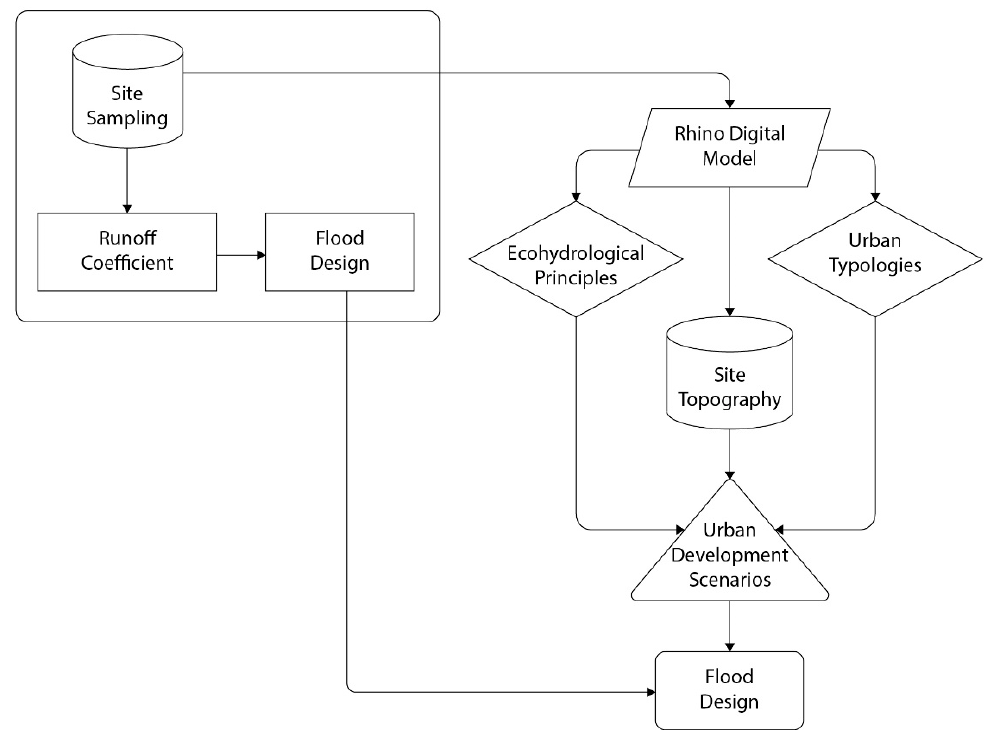
Figure 3. Workflow diagram showing information processing of flood design calculations.